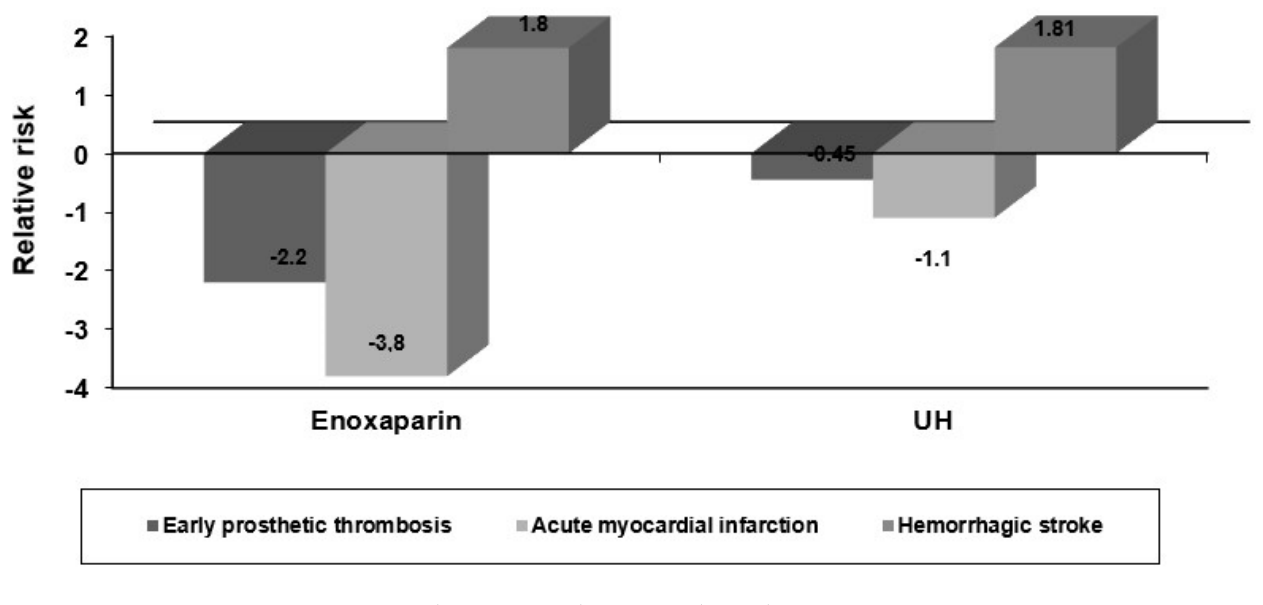
Figure 4. Early major complications in the study groups.